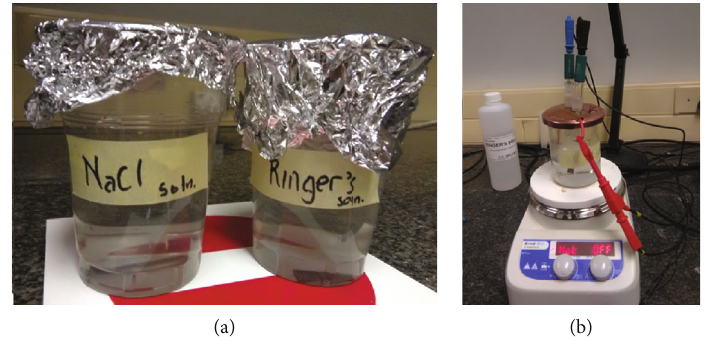
Figure 1: Immersion test using NaCl and Ringer ’ s solutions (a) and polarization test (b).